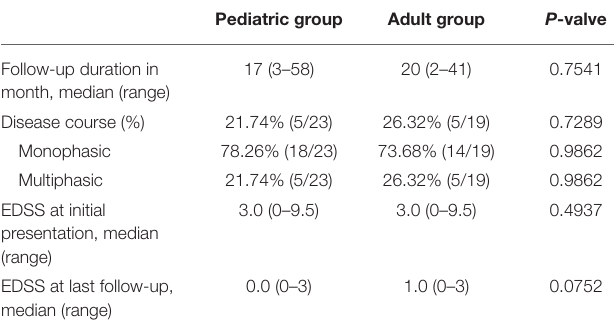
TABLE 4 | Disease course and EDSS scores of the pediatric and adult patients with MOG-EM. Pediatric